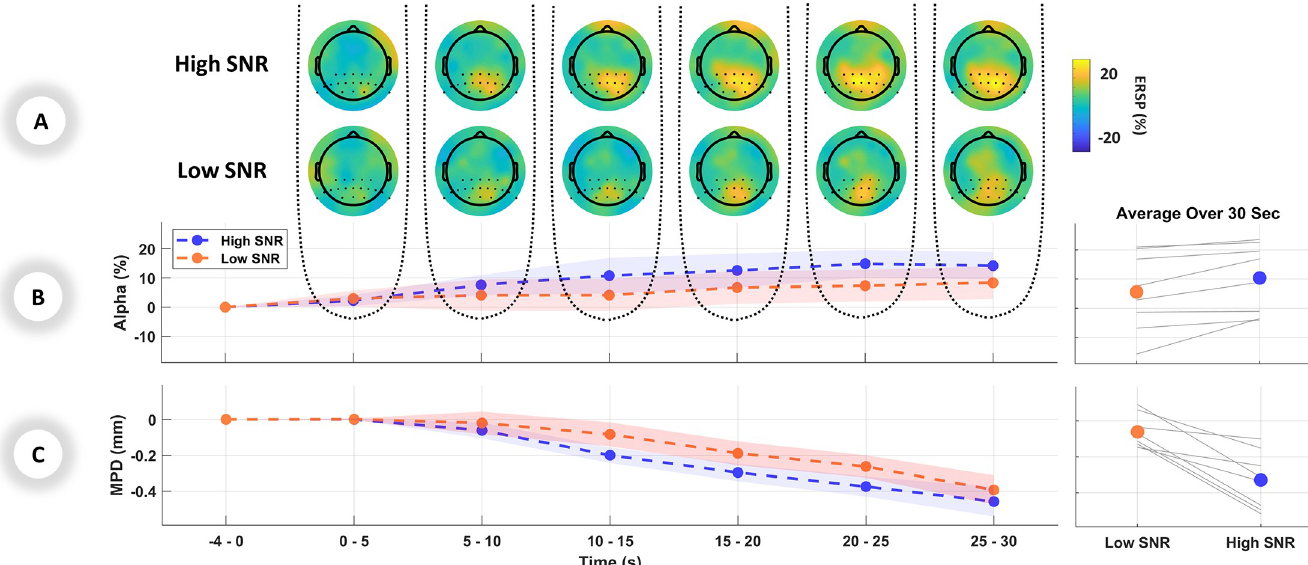
Fig 2. Listening effort indicated by physiological measurements: A) Grand average EEG topographical maps in windows of 5 seconds during presentation of stimuli. The first and second rows show the topographical maps for high SNR and low SNR respectively. B) Left panel: ERSP changes in percentage for the alpha band over the parietal region, averaged over each 5-second period. Right panel: Individual and mean average of parietal alpha over 30 seconds C) Left panel: MPD changes in millimeters for the pupillometry data, averaged over each 5-second period. Right panel: Individual and mean average of MPD over 30 seconds. Standard errors are shown as shaded area in B and C